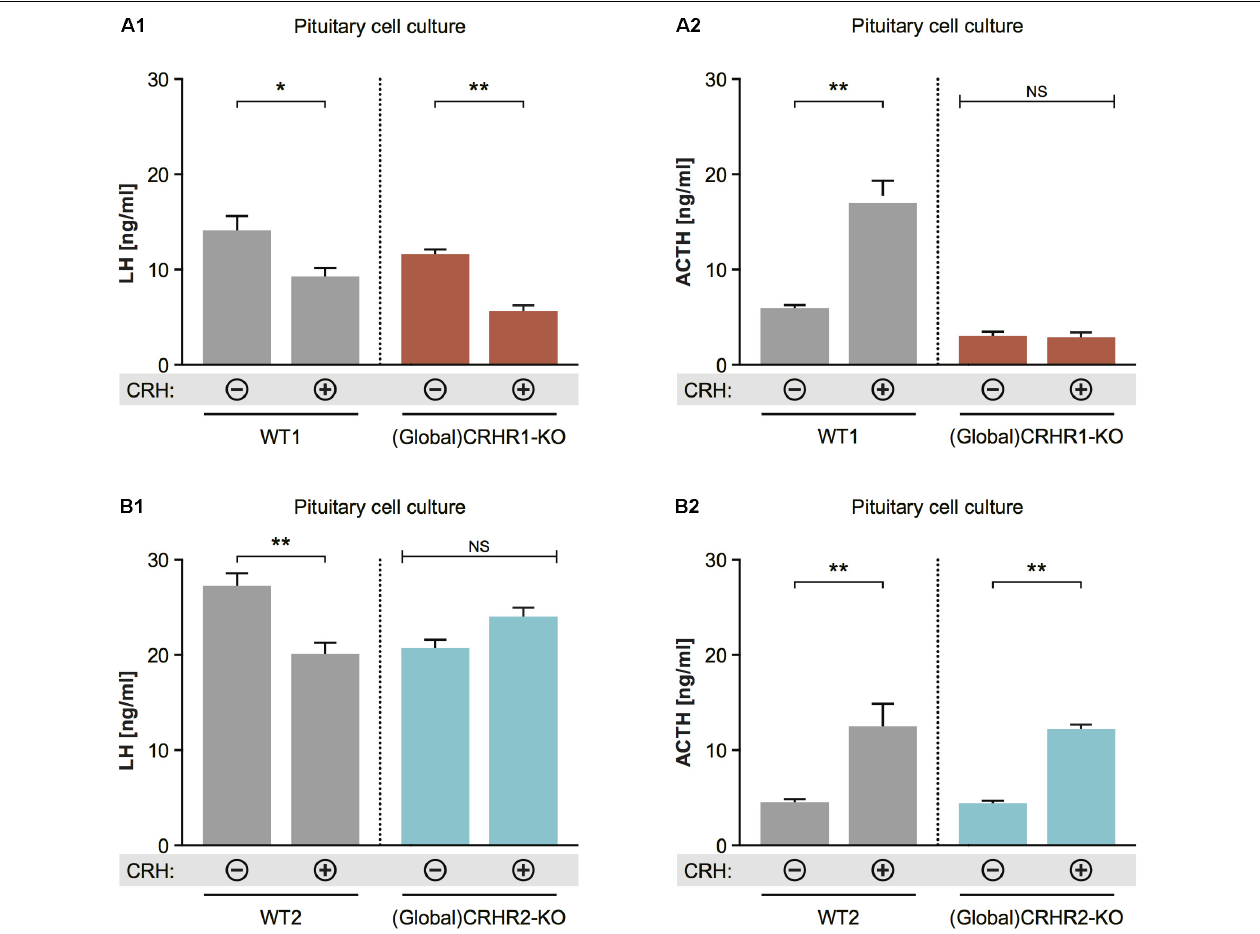
FIGURE 6 | Effect of CRH on LH release from pituitaries of mice lacking CRHR1 or CRHR2. (A1) CRH application induced significant reduction in LH concentrations in the pituitary cultures of WT and CRHR1-KO mice. Two-way ANOVA, F (1, 8) = 9.412, p = 0.0154, followed by Bonferroni’s multiple comparisons test, CRH(+):WT1 vs. CRH(–):WT1, ∗ p = 0.0187, and CRH(+):(Global)CRHR1-KO vs. CRH(–):(Global)CRHR1-KO, ∗∗ p = 0.0044. (A2) ACTH concentrations were increased in the medium of pituitary cells from WT mice, but not from functional CRHR1-KO mice. Two-way ANOVA, F (1, 8) = 53.21, p < 0.0001, followed by Bonferroni’s multiple comparisons test, CRH(+):WT1 vs. CRH(–):WT1, ∗∗∗ p = 0.003, whereas CRH(+):(Global)CRHR1-KO vs. CRH(–):(Global) CRHR1-KO, NS. (B1) CRH application induced significant reduction in LH concentrations in the culture medium of WT mice, but not in that of CRHR2-KO mice. Two-way ANOVA, F (1, 10) = 17.32, p = 0.0020, followed by Bonferroni’s multiple comparisons test, CRH(+):WT vs. CRH(–):WT2, ∗∗ p = 0.0031 and CRH(+):(Global)CRHR2-KO vs. CRH(–):(Global)CRHR2-KO, NS, p > 0.05. (B2) ACTH levels in the medium of pituitary cell of WT littermates and global CRHR2-KO mice were equally increased after CRH stimulation in comparison to non-stimulated conditions. Two-way ANOVA, F (1, 10) = 34.75, p = 0.0002, followed by Bonferroni’s multiple comparisons test, CRH(+):WT vs. CRH(–):WT2, ∗∗ p = 0.0021, and CRH(+):(Global)CRHR2-KO vs. CRH(–):(Global)CRHR2-KO, NS, p = 0.0065.